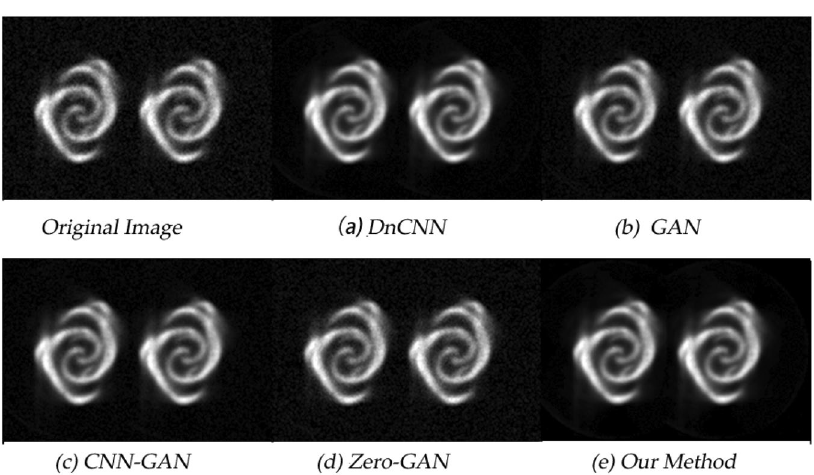
Figure 7. The positron flow field images are the vortex images obtained by simulation. The specific parameters are sampling time 1s and nuclide activity 800 bq.